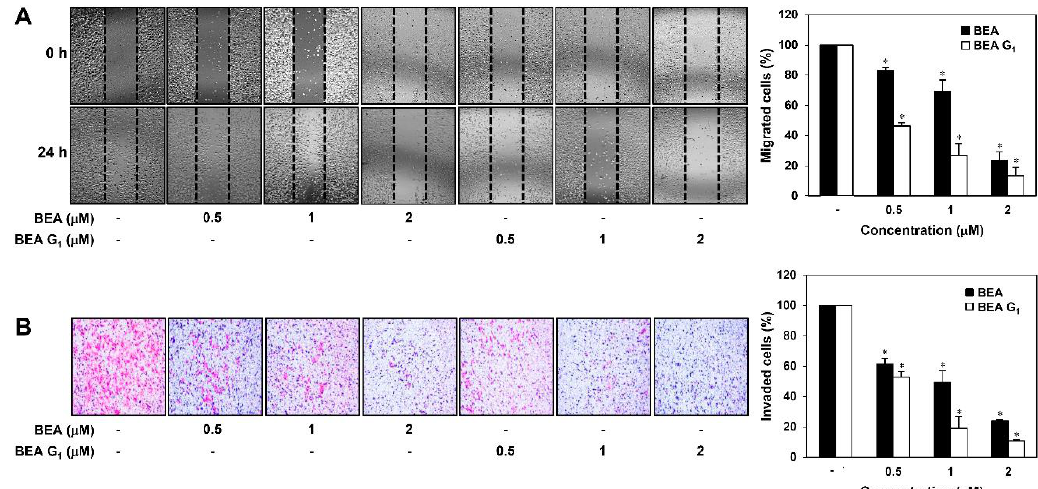
Figure 3. Migration inhibitory effects of BEA and BEA G 1 on A375SM melanoma cells. ( A ) The effects of BEA and BEA G 1 on the migration of A375SM cells. The migratory potential of A375SM cells was analyzed using a wound healing assay. The cells were treated with BEA and BEA G 1 (0.5, 1, and 2 μM) for 24 h. Cells that migrated into the gap were counted using an optical micr oscope. Dotted black lines indicate the edge of the gap at 0 h. ( B ) The effects of BEA and BEA G 1 on the invasion of A375SM cells. The invasiveness of A375SM cells was analyzed using Matrigel-coated polycarbonate filters. The cells were treated with BEA and BEA G 1 (0.5, 1, and 2 μM) for 24 h. Cells that penetrated the filters were stained and counted using an optical microscope. * = p < 0.05 versus the control.